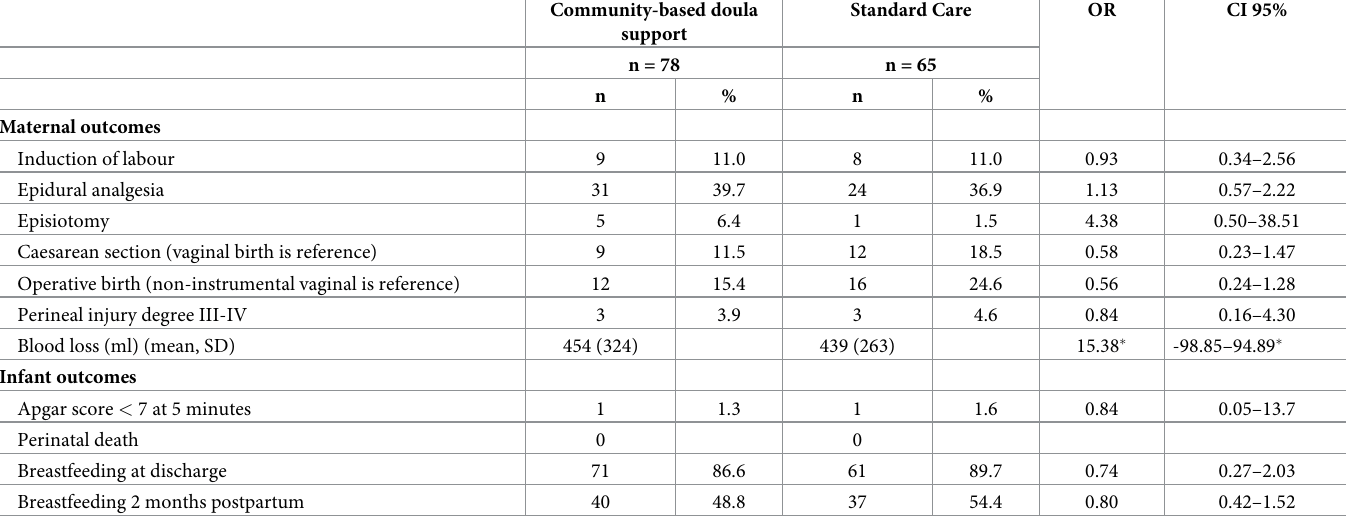
Table 4. Obstetric outcomes for women with CBD support or standard care during labour and birth (n =